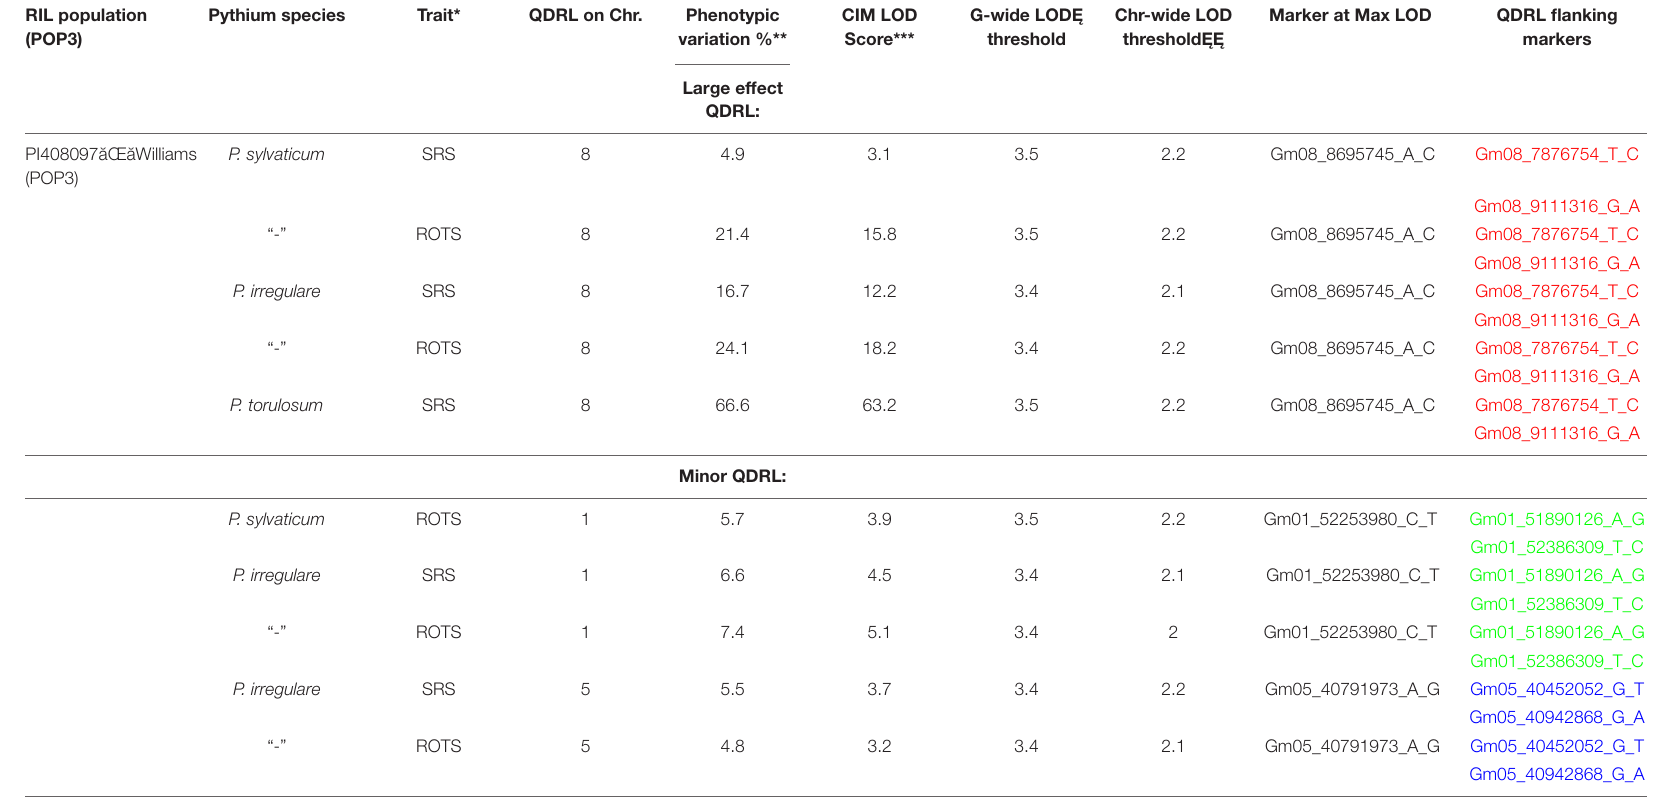
Common QDRL positions within the same population for multiple traits and/or species are shown in the same color. *SRS, seed rot severity; ROTS, percent rotted seeds in inoculated plates. **Phenotypic variation explained by the individual QDRL. ***LOD score calculated by composite interval mapping. † Genome-wide threshold for LOD. †† Chromosome-wide threshold for